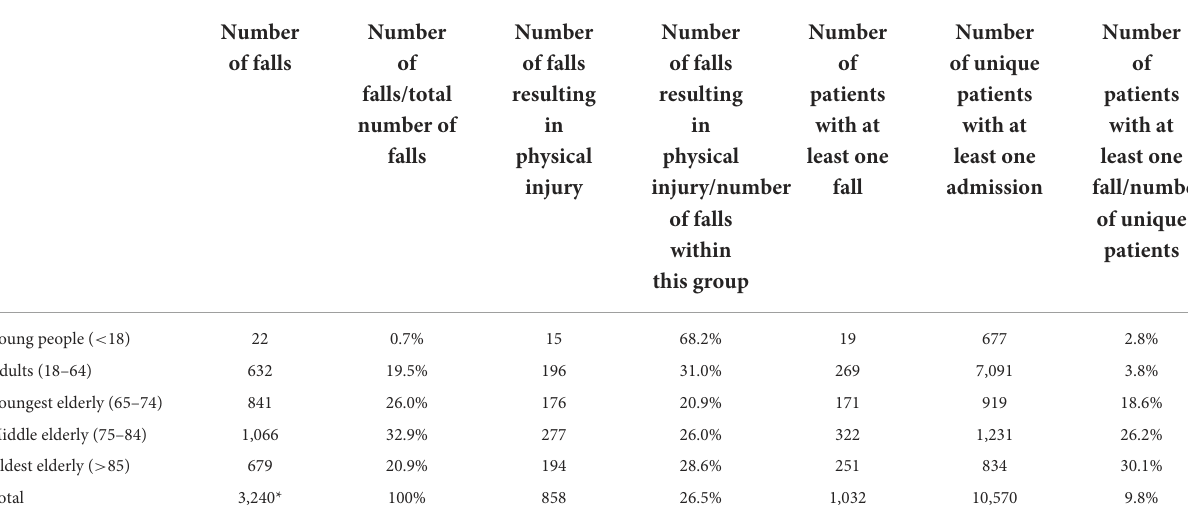
TABLE 3 Data on the number of falls, number of falls resulting in physical injury, number of patients with a fall and number of admissions, expressed in relation to age. Number of